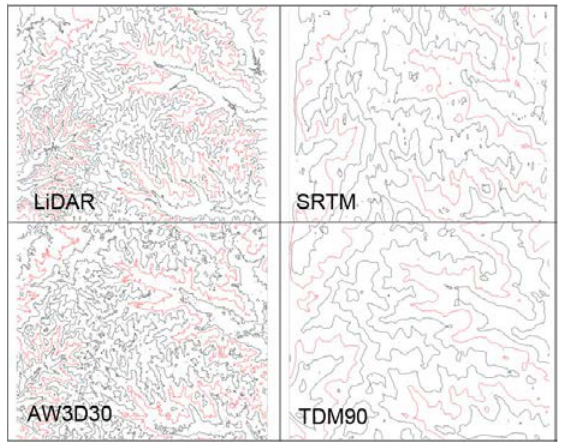
Figure 8. Contour lines test site Flat, contour interval 10m